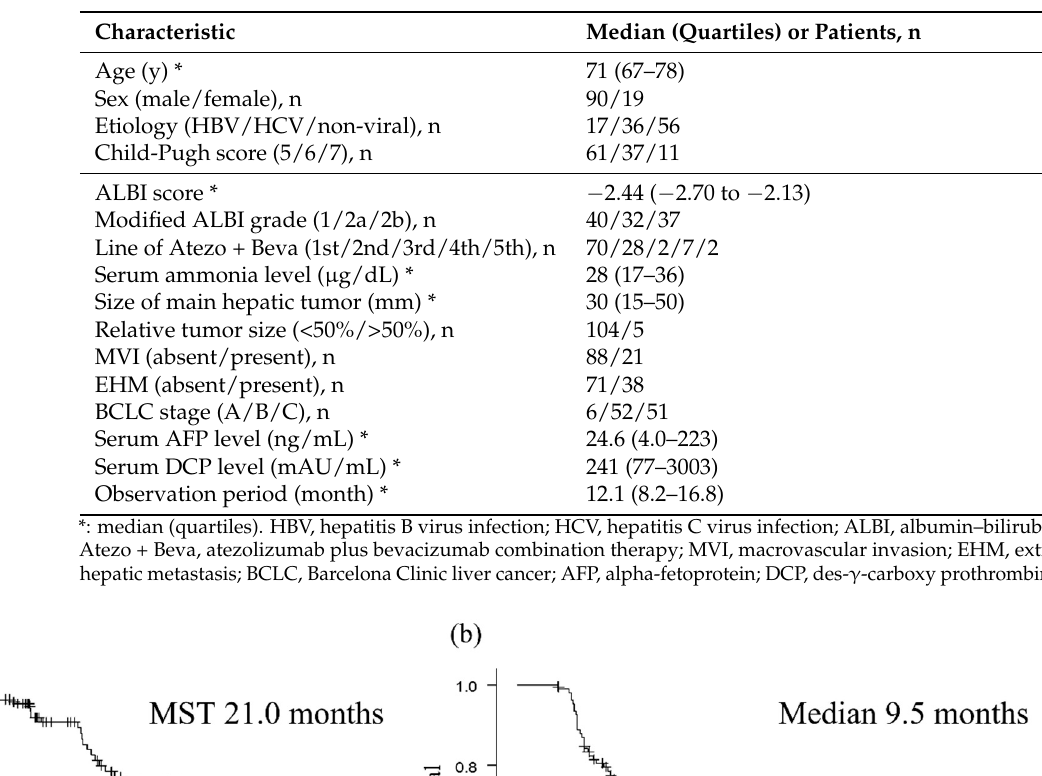
Table 1. Clinical characteristic at the initiation of atezolizumab plus bevacizumab combination therapy (n = 109).